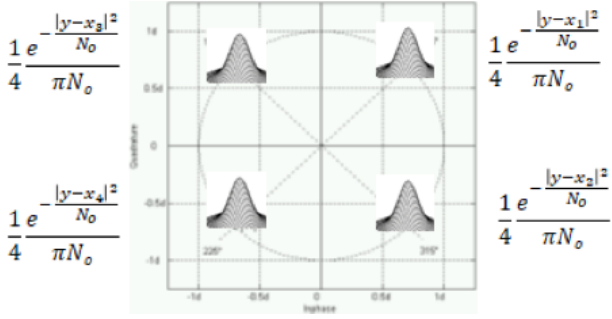
Figure 1. Mixture random variable Y for QPSK data symbol.